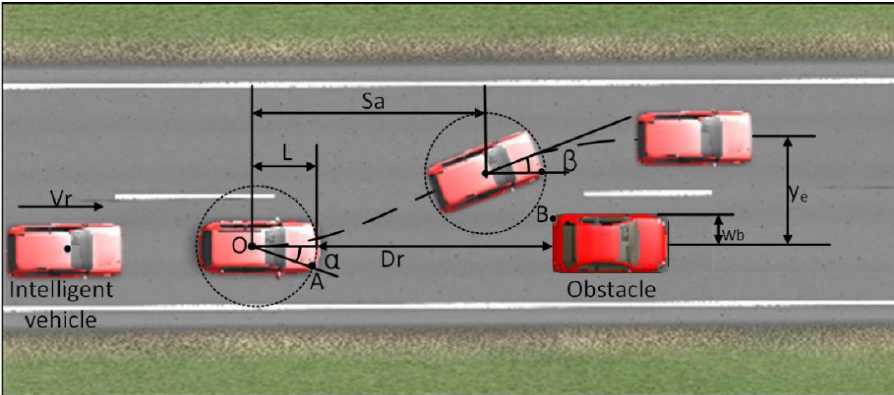
Figure 2. Intelligent vehicle lateral collision avoidance